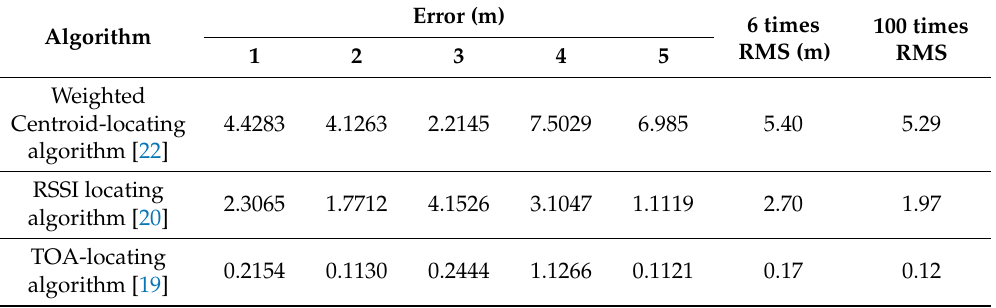
Table 1. Comparison with root mean square (RMS) error value for the weighted